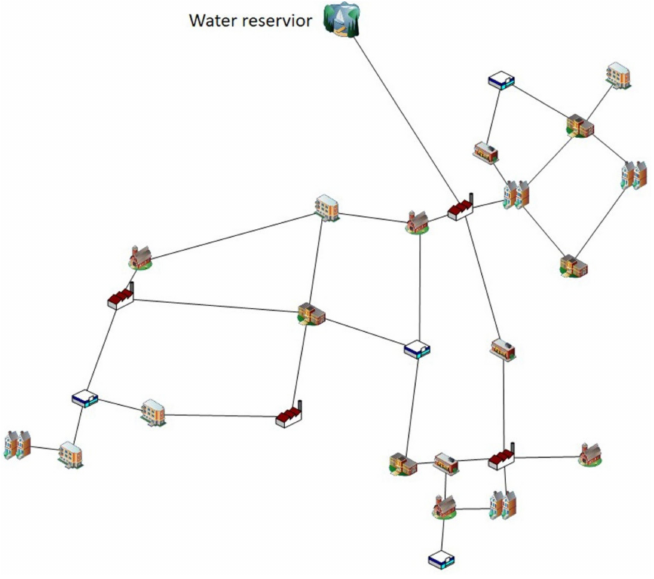
Figure 4. Jilin Network